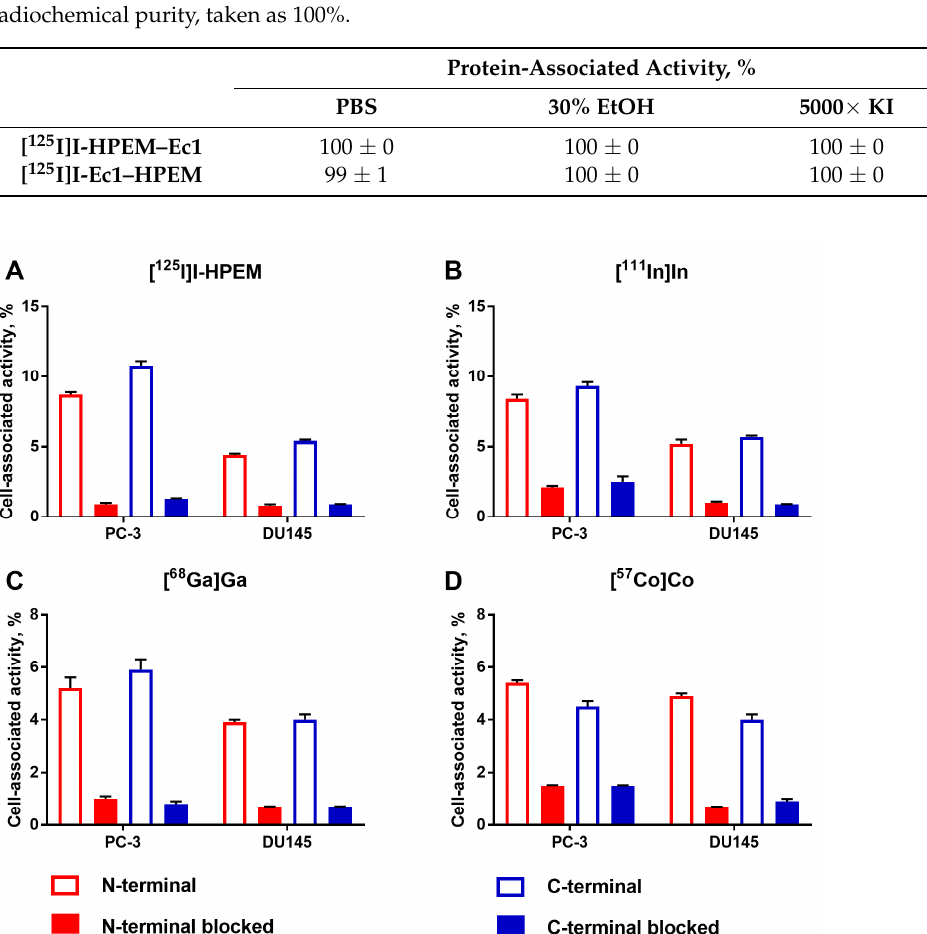
Table 3. In vitro stability of radioiodinated Ec1 conjugates. The conjugates were incubated for 3 h with 30% ethanol or with a 5000-fold molar excess of KI in PBS and compared to PBS control. Analysis was performed in duplicates. The values for each conjugate were normalized to its starting radiochemical purity, taken as 100%.